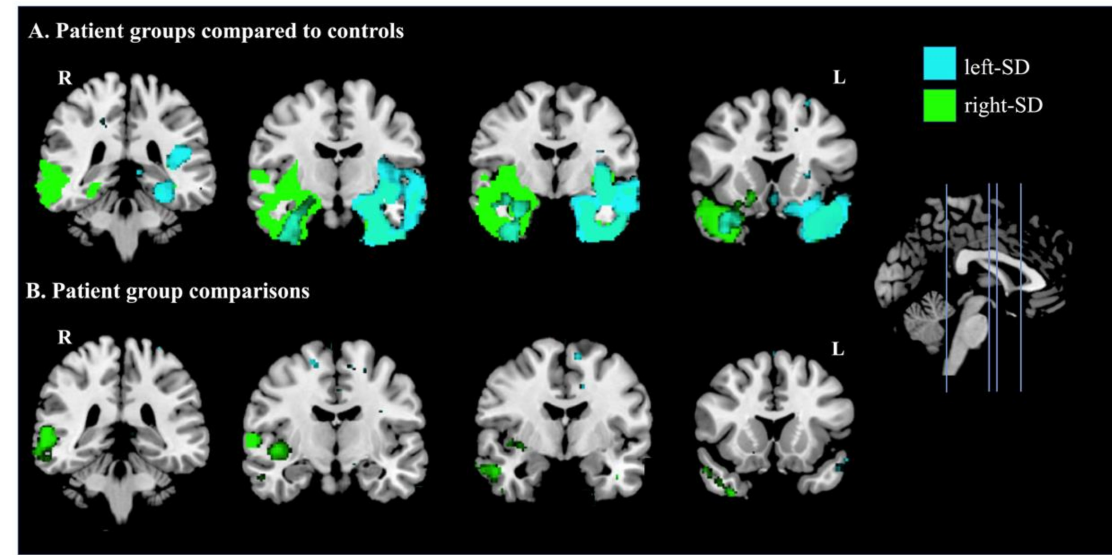
Figure 5. Patterns of atrophy in A : left-lateralised semantic dementia (left-SD) compared to controls (cyan) and right- lateralised semantic dementia (right-SD) compared to controls (green); and B: where left-SD showed lower intensity than right-SD (cyan) and where right-SD showed lower intensity than left-SD (green). Coloured voxels show regions that were significant in a voxel-wise analysis at p < 0.005, uncorrected, with a cluster extent threshold of 150 voxels. MNI coordinates: x = 0; y = − 36, − 10, − 4, 16 (left to right). L = left; R =